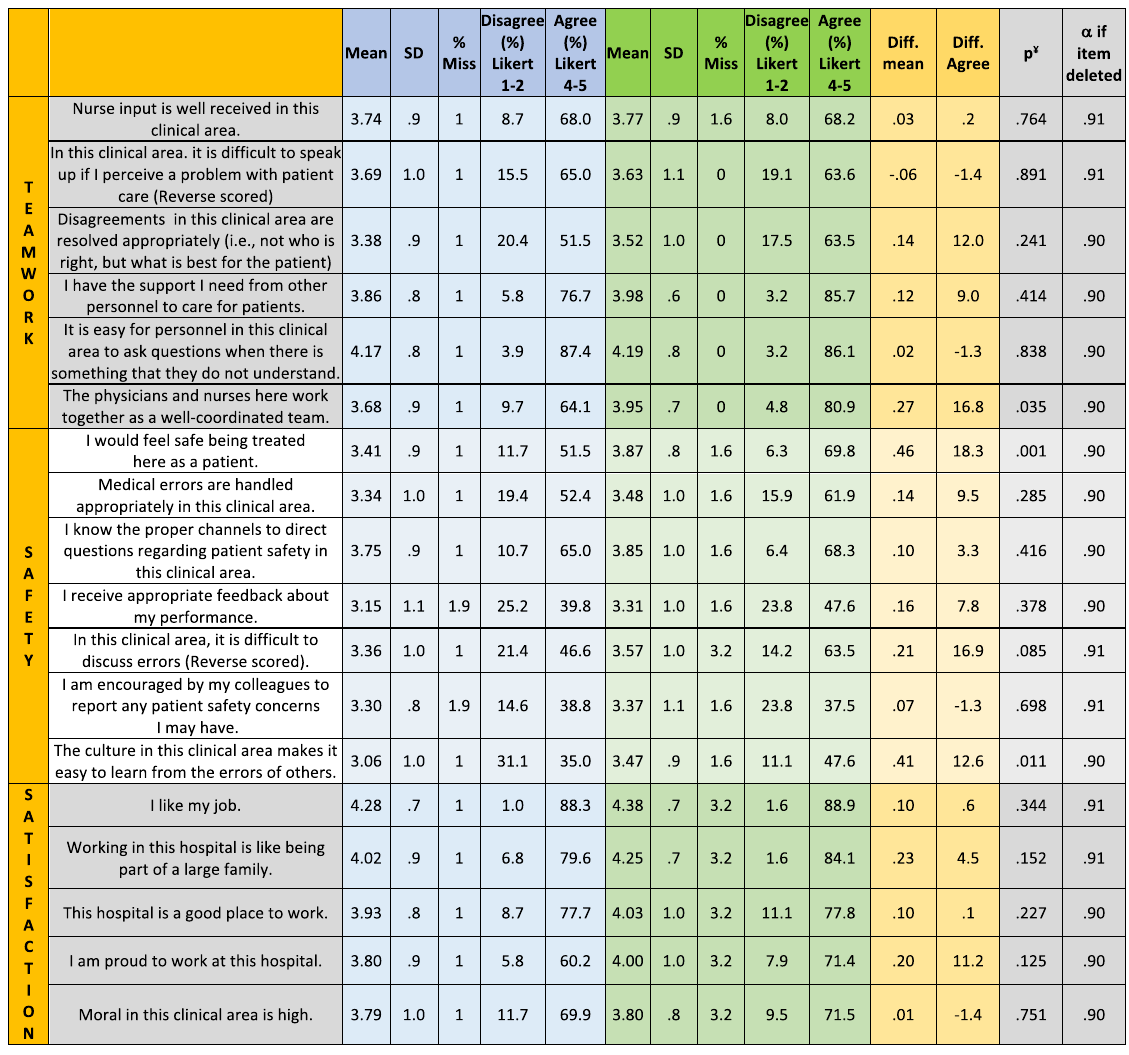
Table 1 Safety attitudes questionnaire (SAQ) domain item